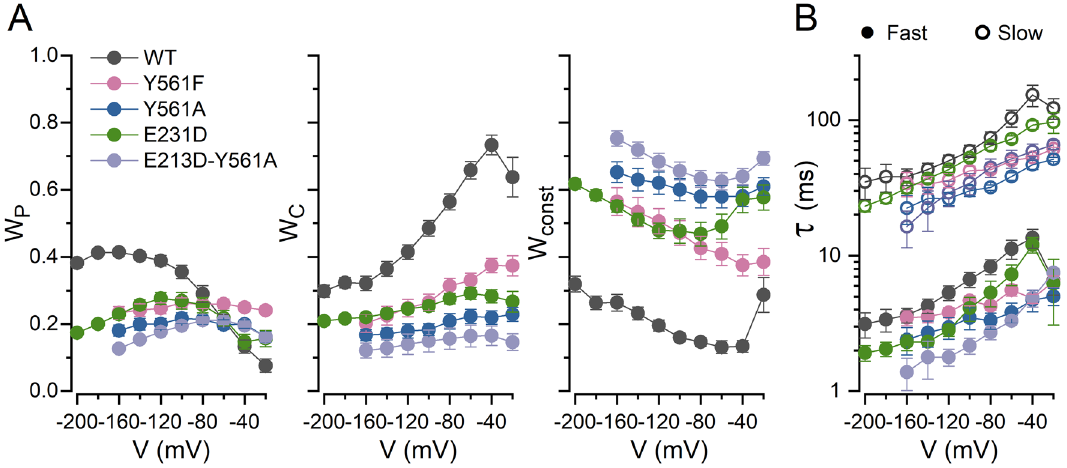
Figure 3. Kinetics analysis of WT and Y561 and E213 mutant channels. (A) The relative contribution of fast (W P ), slow (W C ) and constant (W const ) components of the total Cl − current generated by the colour coded indicated channels. (B) Voltage dependence of fast (τ f , closed circles) and slow (τ s , open circles) time constants of the Cl − currents generated by the channels indicated in (A) . Whole cell Cl − currents were fitted with a biexponential function (Eq. 2) to determine W p , W C , W const , τ f , and τ s